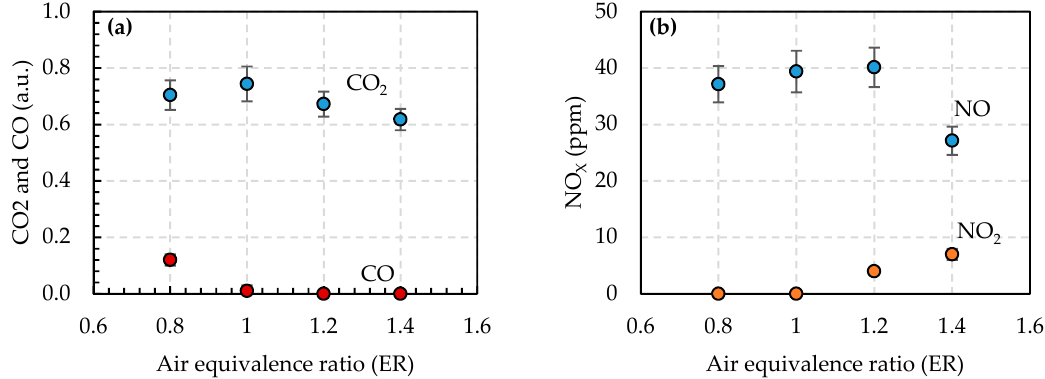
Figure 3. The effect of ER on the ( a ) relative concentrations of CO 2 and CO and ( b ) concentration of NO and NO 2 in the exhaust gas of the gas burner.